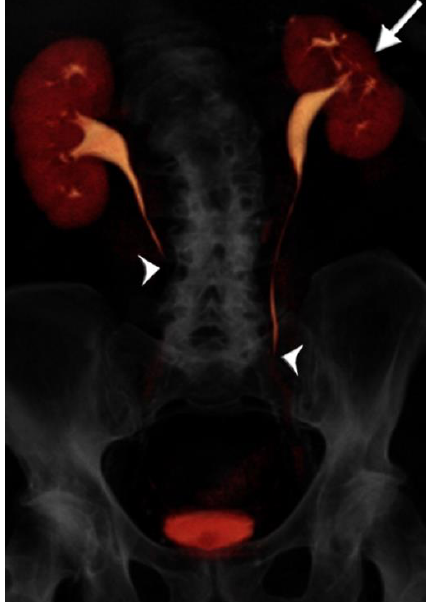
Figure 3. 73 year-old male with microhematuria imaged with split-bolus CT urography. Volume- rendered image of the first excretory phase shows no contrast opacification of the mid-distal ureters (arrowheads). There is cortical scarring of the left kidney from previous nephrectomy for renal cell carcinoma (arrow). On repeat acquisition of the excretory phase, no improvement in image quality was achieved. The total table time was 17 min and the dose-length product was 1731 mGy·cm.